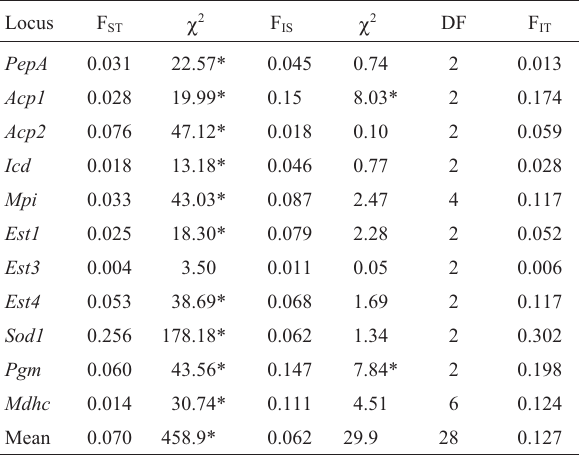
Table 3 - F-statistics coefficients and the respective chi-squares determined by enzyme loci in Digelasinus diversipes . Locus